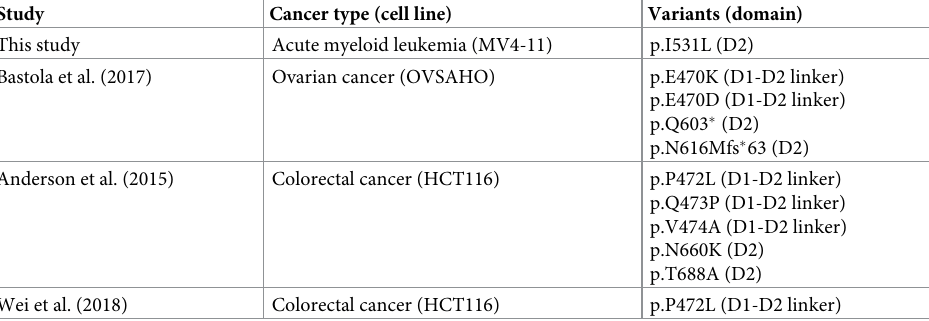
Table 1. Potential CB-5082 resistance mutations characterized in this and previous